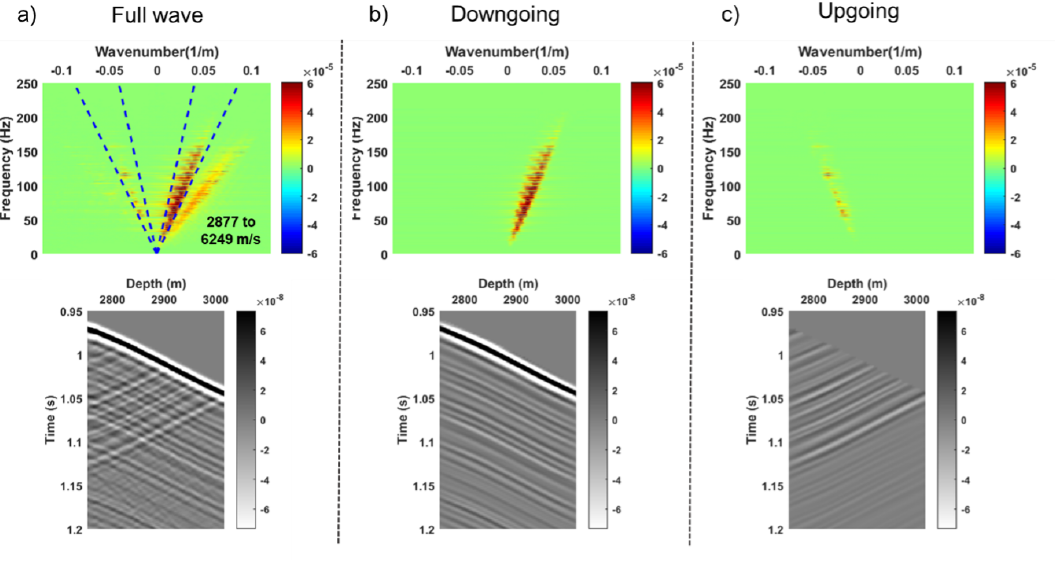
Figure 9. Wavefield separation of synthetic shot data in the f - k domain with a physical source at the surface. ( a ) The up- and downgoing wave and its f - k spectrum. ( b ) Downgoing wave and its f - k spectrum. ( c ) Upgoing wave and its f - k